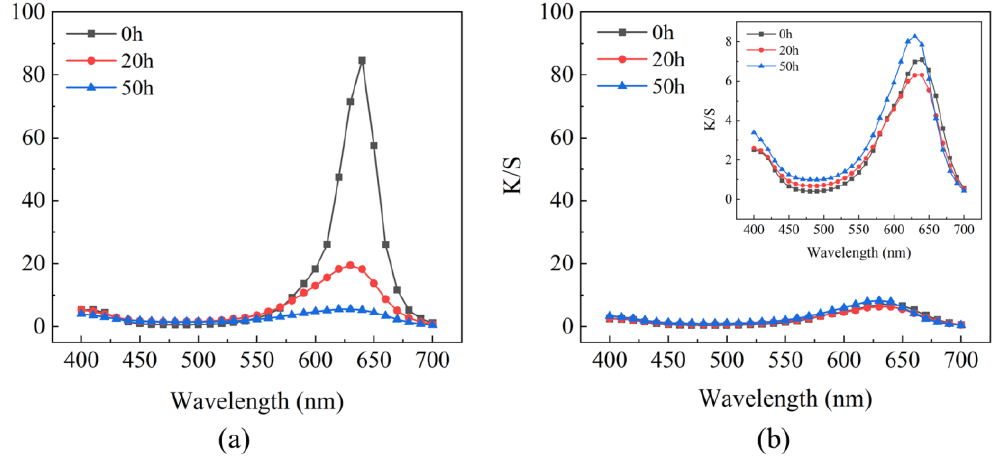
Figure 8. ( a ) K/S spectra of untreated dyed wood and ( b ) treated wood irradiated at 0, 20, and 50 h UV light.